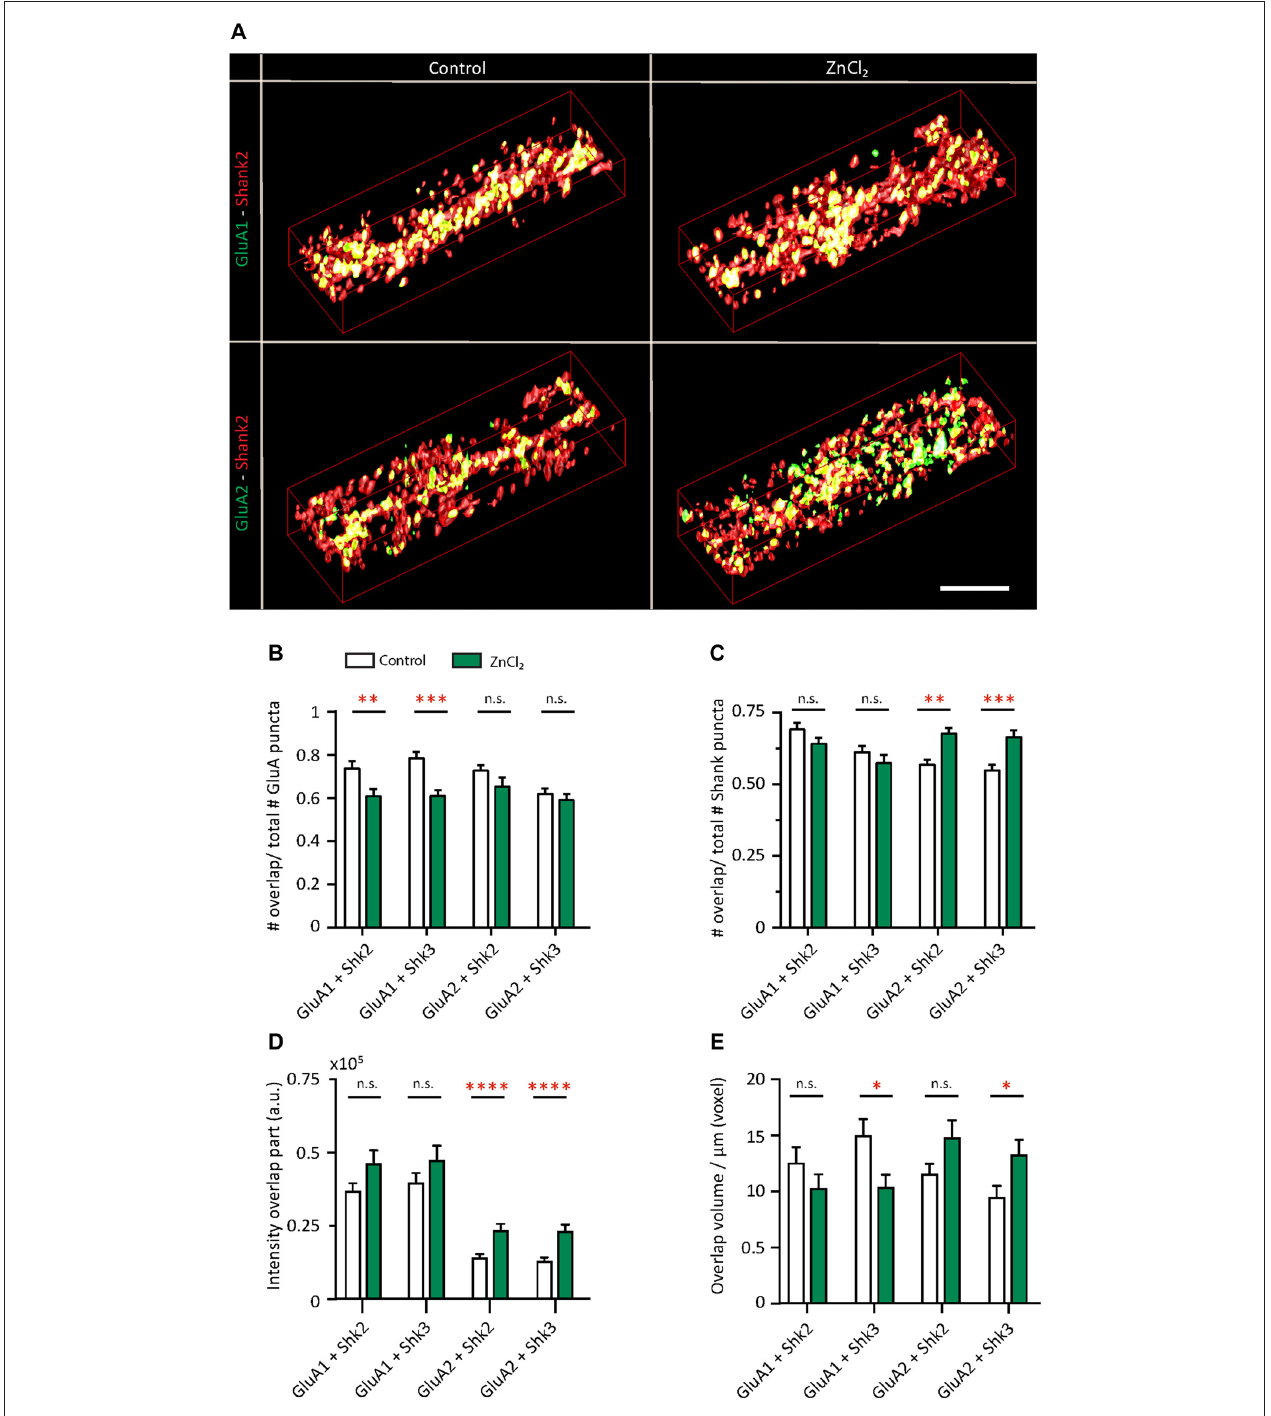
FIGURE 8 | Zinc treatment alters the colocalization between AMPAR subunits and Shank. (A) Straightened dendrites from young hippocampal neurons (DIV 14) treated with control (left) or 10 µ M ZnCl 2 (right). Neurons were live surface labeled for GluA1 (green; top) or GluA2 (green; bottom) before being fixed and co-immunostained for both Shank2 (red) and Shank3 (not shown). Yellow indicates colocalization. Scale bar: 4 µ m. (B–E) Three-dimensional colocalization analysis of pairwise puncta overlap using IMFLAN3D as measured by the fraction of overlap (B,C) , intensity (D) and volume (E) for baseline and ZnCl 2 conditions (mean ± SEM) [Mann-Whitney test, for GluA1 + Shank3 or Shank2, N = 19 (control) and 22 (ZnCl 2 ) dendrites from 10 to 14 neurons from two culture preps; for GluA2 + Shank3 or Shank2, N = 24 dendrites from 10 to 14 neurons from two culture preps; for Shank2 + Shank3, N = 43 (control) and 46 (ZnCl 2 ) dendrites from 20 to 25 neurons from four culture preps; n.s. p ≥ 0.05, ∗ p < 0.05, ∗∗ p < 0.01, ∗∗∗ p < 0.001, ∗∗∗∗ p <